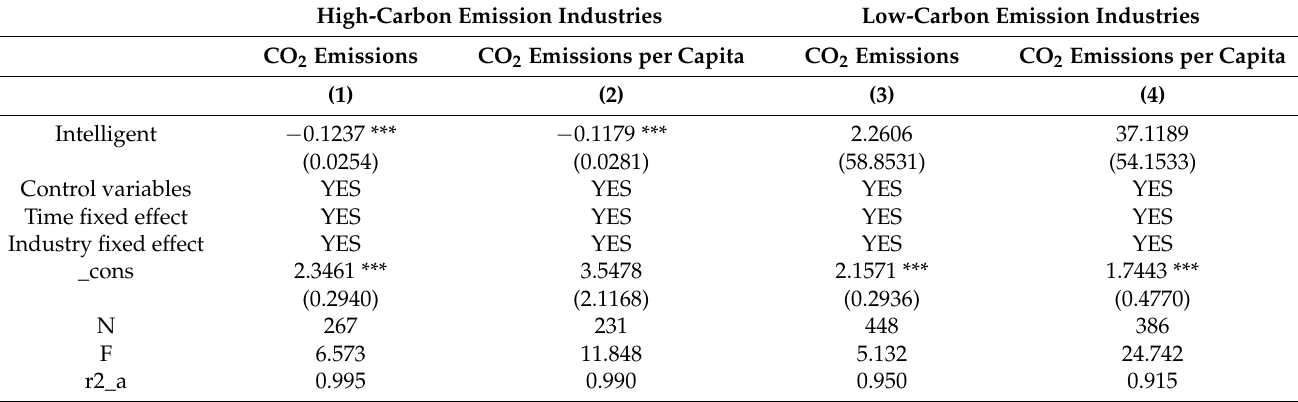
Table 4. The impact of intelligent manufacturing on carbon emissions under carbon emission